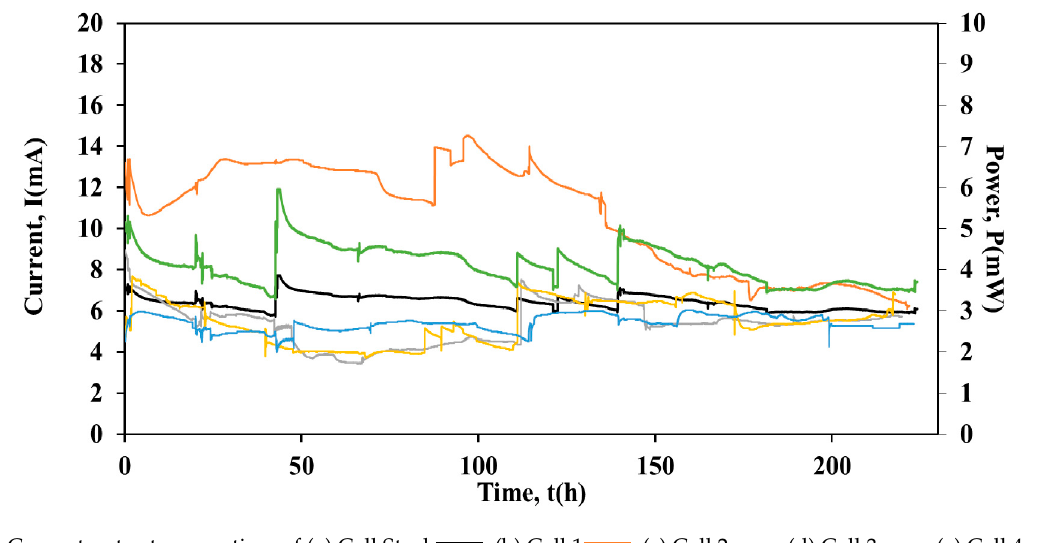
Figure 5. Current output versus time of (a) Cell Stack and power versus time of (f) Cell stack , during series connection.